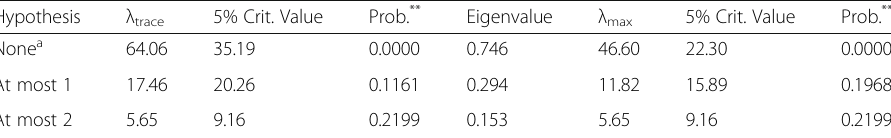
Table 5 Johansen and Juselius cointegration Hypothesis λ trace 5% Crit. Value At most 1